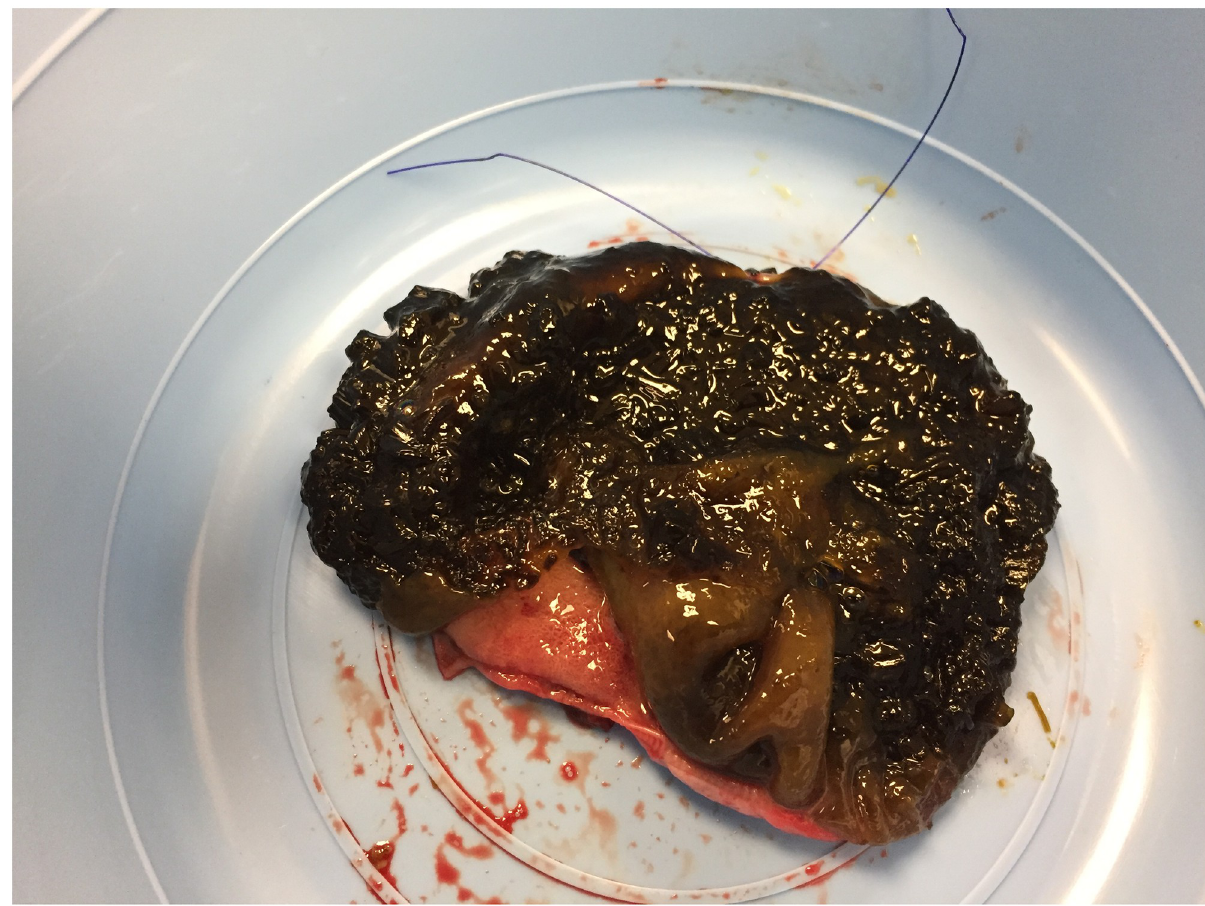
Fig 4. Interior appearance of a gallbladder mucocele after surgical removal from a dog. The gallbladder was opened lengthwise exposing the intraluminal mucus content which served as the source of sample used for 16S rRNA gene sequencing.